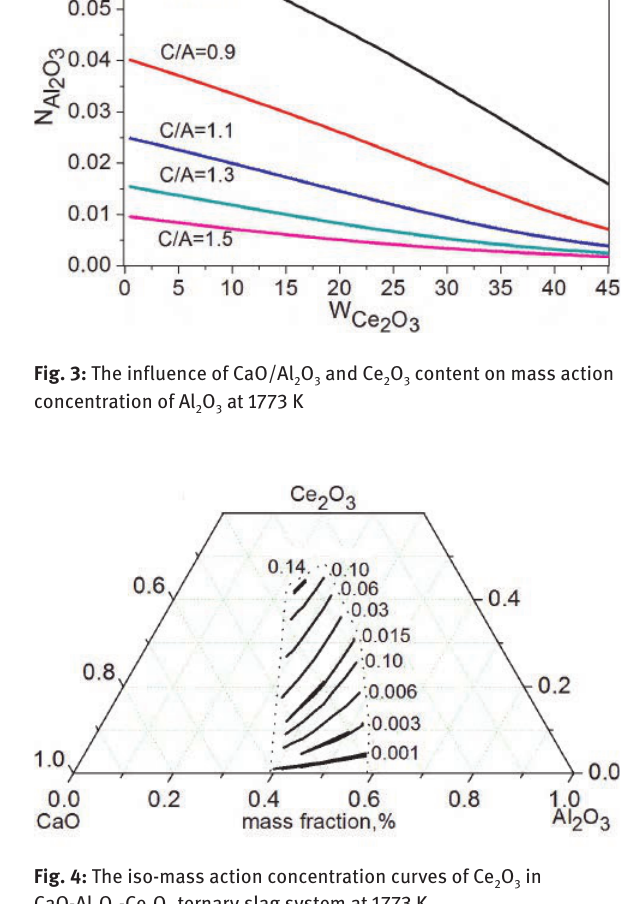
⋅ Al O , Al O and Ce O O 2 3 2 3 2 3 2 3